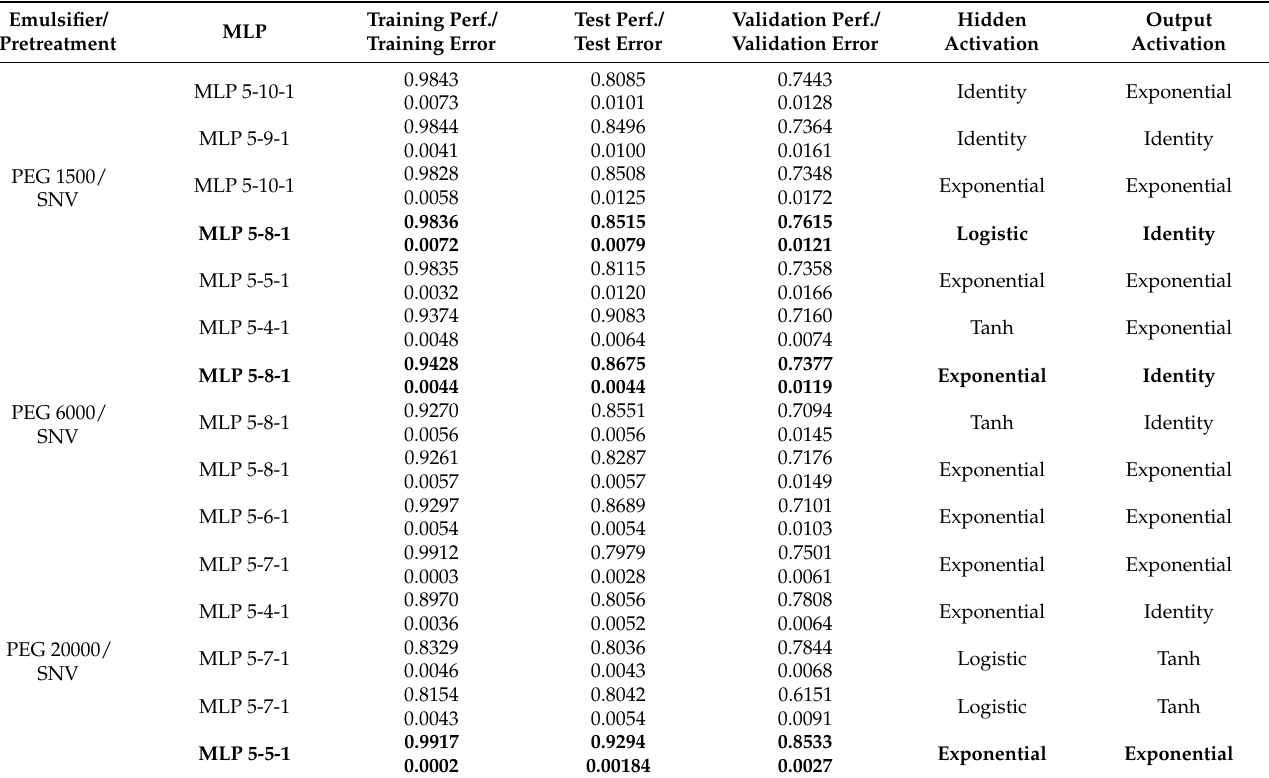
Table 3. Characteristics of ANN networks selected for the prediction of the average droplet sizes of oil-in-water and oil-in-aqueous mint extract (green shading) emulsions prepared in a microfluidic device at different flow rates using different emulsifiers based on different NIR spectra pretreatments. Training Perf./ Emulsifier/ MLP Training Pretreatment